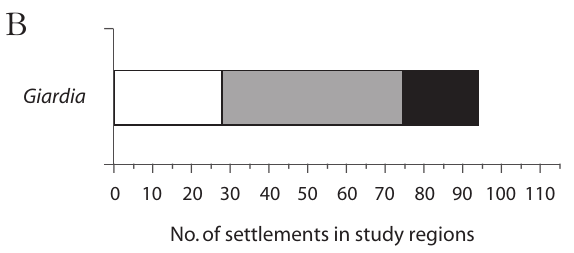
Fig. 1. – Asymptomatic human Giardia infection in Central Serbia: (A) map with prevalence (%) in 20 study regions and (B) distribution of prevalence in 115 settlements throughout Central